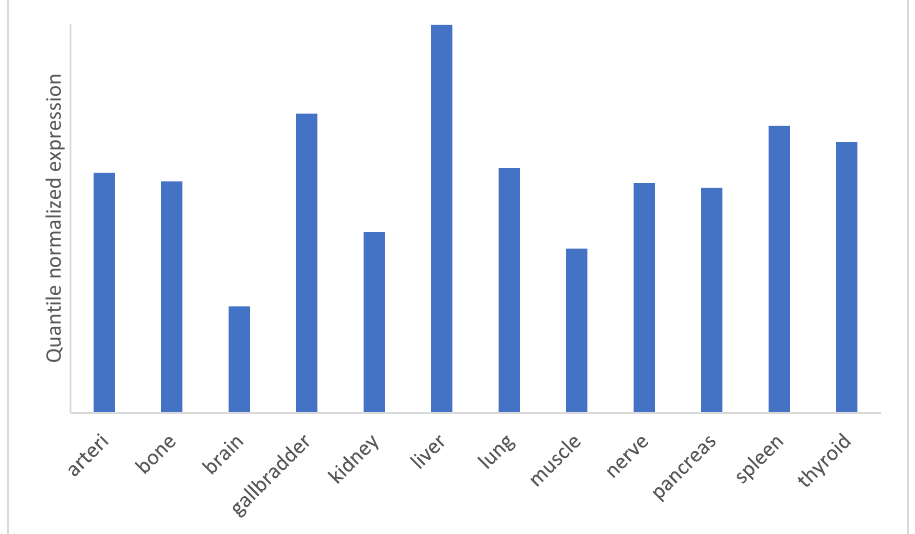
Figure 2. Expression plot of miR-122 in different organs. The expression of miRNA within different organs was calculated by tissue specificity index (TSI). Adapted from the tissue atlas [https://ccb-web.cs.uni-saarland.de/tissueatlas/ (accessed on 28 August 2022); [32]]. The maximum expression value for selected human organs is visualized. For best visualization, the quantile normalized expression is represented in the decimal logarithmic scale.